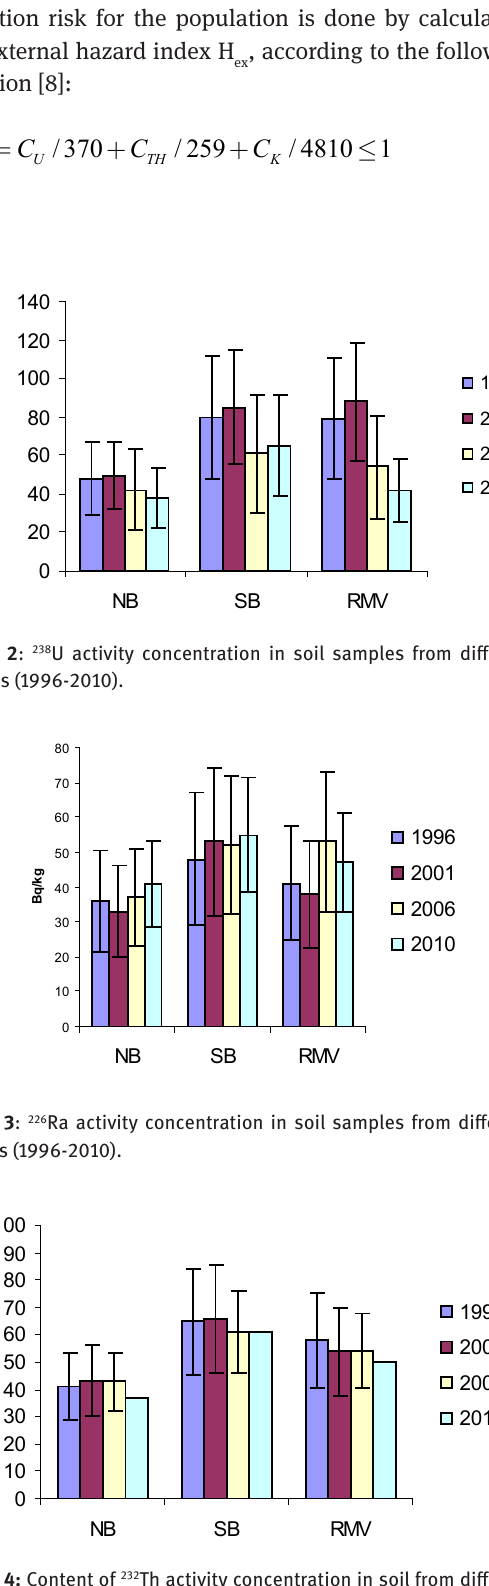
Figure 1 : Principle scheme of the analytical procedure used for uranium isotopes determination.